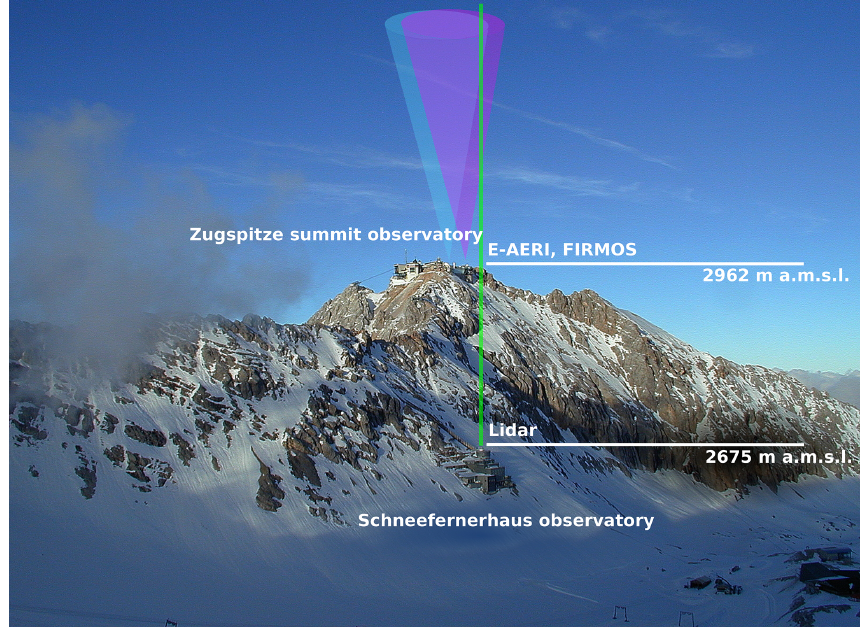
Figure 1. Summit and Schneefernerhaus stations at Mt. Zugspitze,